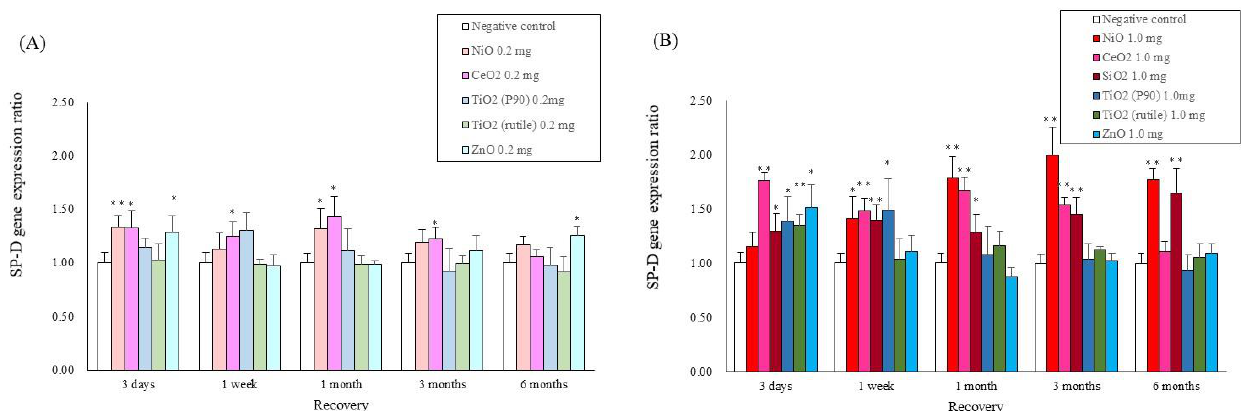
Figure 4. Gene expression of SP-D in lung exposed to nanomaterials with different pulmonary toxicities: ( A ) SP-D gene expression in low dose of intratracheal instillation, ( B ) SP-D gene expression in high dose of intratracheal instillation. Error bars represent mean ± SD for n = 5/group. Asterisks indicate significant differences compared with each control (Analysis of variance and Dunnett’s test) (* p < 0.05, ** p < 0.01). An average of negative controls in all experiments at each time point showed a single bar of negative control.